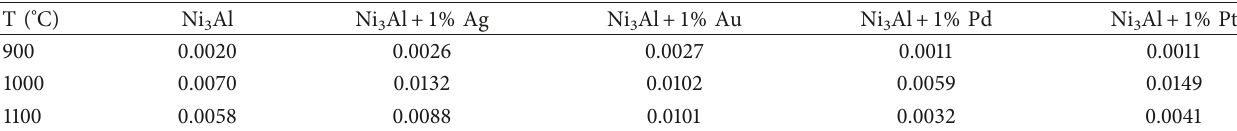
° C, (b) 1000 ° C, and (c) 1100 ° C. p from Figure